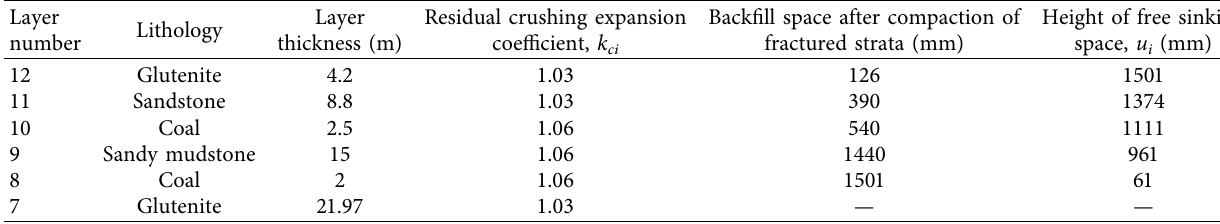
Table 4: Free subsidence space of overlying strata.